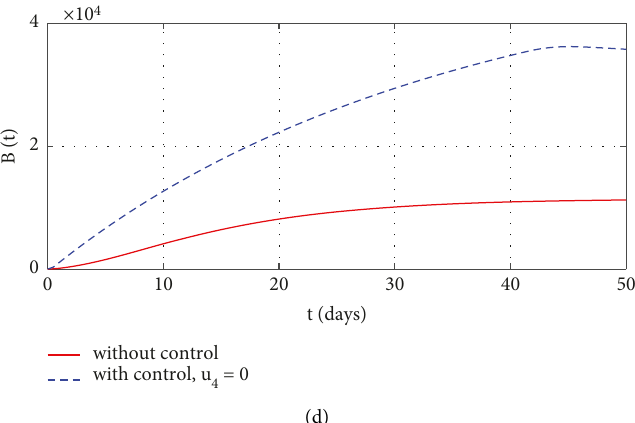
Figure 5: Simulations of the cholera model showing the effect of optimal control strategy with vaccination, hygiene, and chlorination control